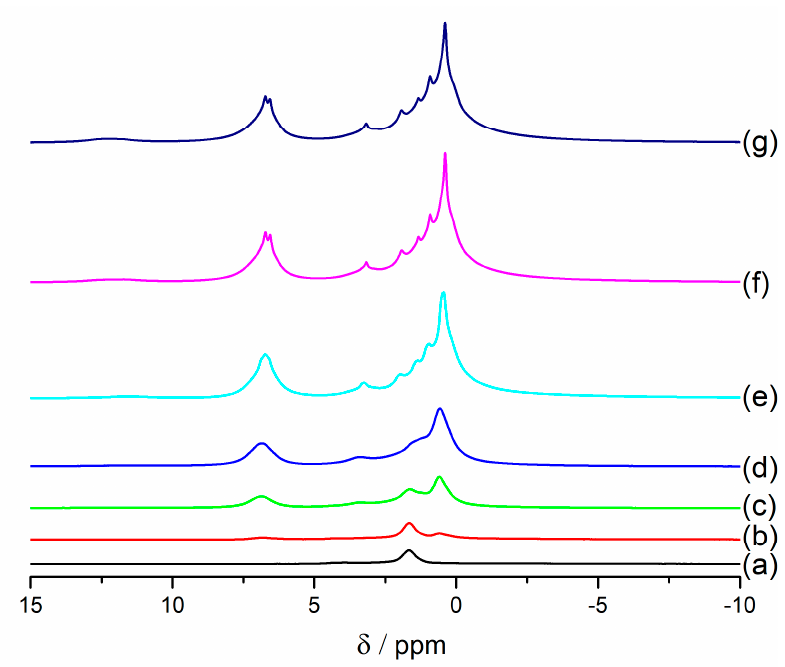
Figure 6. 1 H MAS NMR spectra of FAU31 sample after dehydration in vacuum at 300 °C ( a ) and samples containing: 3% ( b ), 9% ( c ), 15% ( d ), 34% ( e ), 46% ( f ), 66% ( g ) of mass % of ibuprofen in dehydrated zeolite. All the spectra were recorded in 295 K. Samples were measured using 3.2 mm rotors and with 12 kHz rotation.